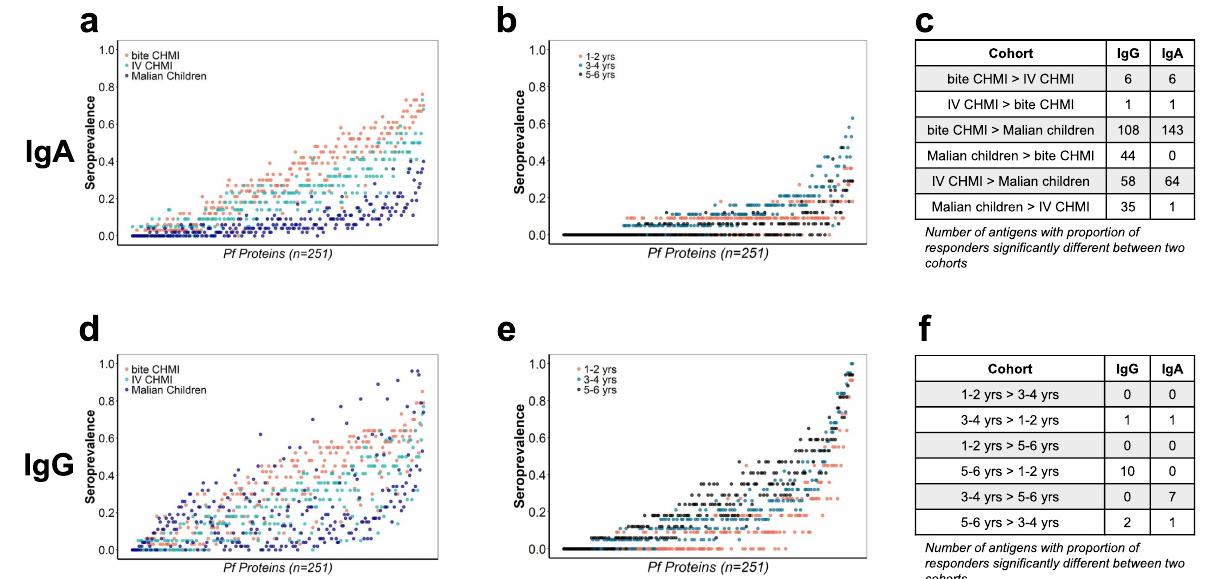
Fig. 4 IgA and IgG seroprevalence for 251 P. falciparum proteins. Proteins are sorted and displayed with greatest overall seroprevalence on the right. Seroprevalence for the bite CHMI, parental CHMI, and Malian children for IgA ( a ) and IgG ( d ). Seroprevalence for three age strata of Malian children for IgA ( b ) and IgG ( e ). The tables show number of antigens with proportion of responders that are signi fi cantly different between two indicated cohorts as indicated for 193 antigens for IgA and 228 antigens for IgG ( c , f ), using a two-proportion z test with Yates continuity correction with p values adjusted using the Benjamini-Hochberg procedure. Data is derived from the post-infection timepoint for Malian children and day 29 for the CHMI studies.